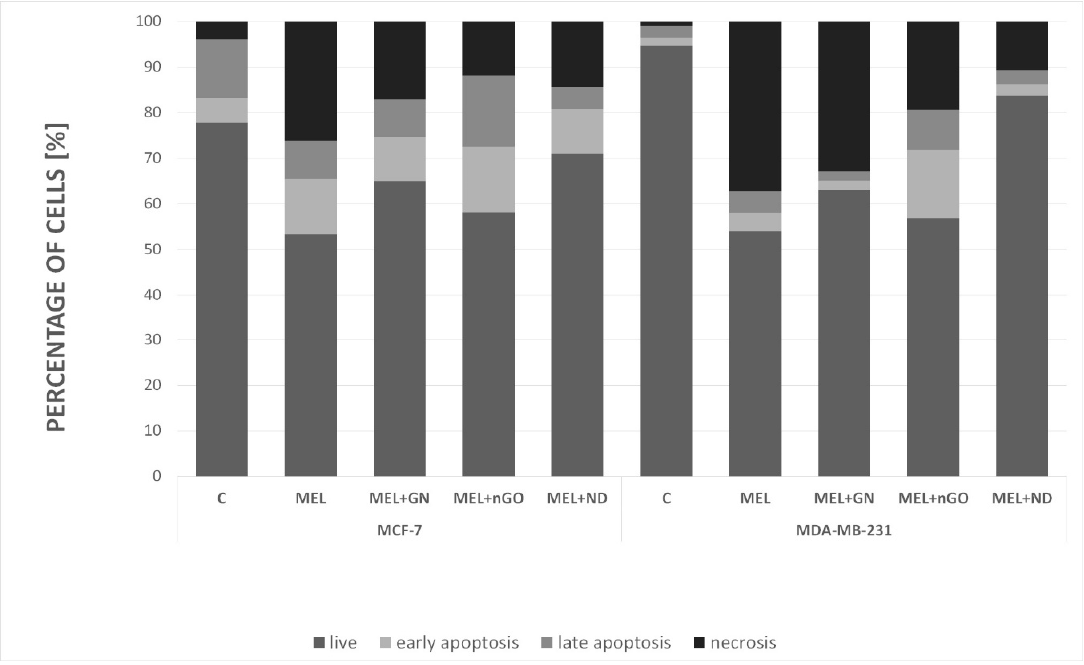
Figure 10. Analysis of cell death type for MCF-7 and MDA-MB-231 cell lines. C—control group; MEL—group treated with melittin at a concentration of 10 mg/L; GN—group treated with natural graphene (20 mg/L ); nGO—group treated with graphene nanoxide (20 mg/L); ND—group treated with nanodiamond (20 mg/L); GN + MEL—group treated with melittin complex (10 mg/L) and natural graphene (20 mg/L); nGO + MEL—group treated with melittin complex (10 mg/L) and graphene nanoxide (20 mg/L); ND + MEL—group treated with melittin complex (10 mg/L ) and nanodiamond (20 mg/L).